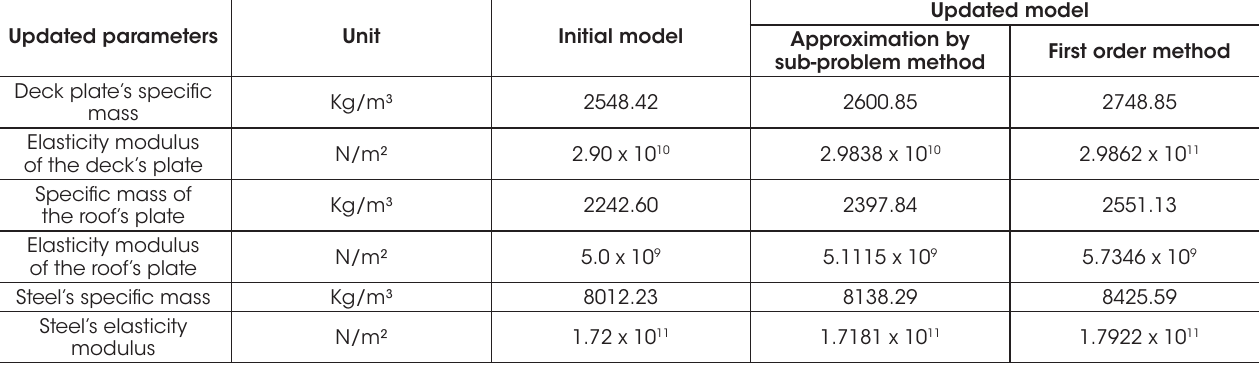
Updated parameters – optimal project – Santos